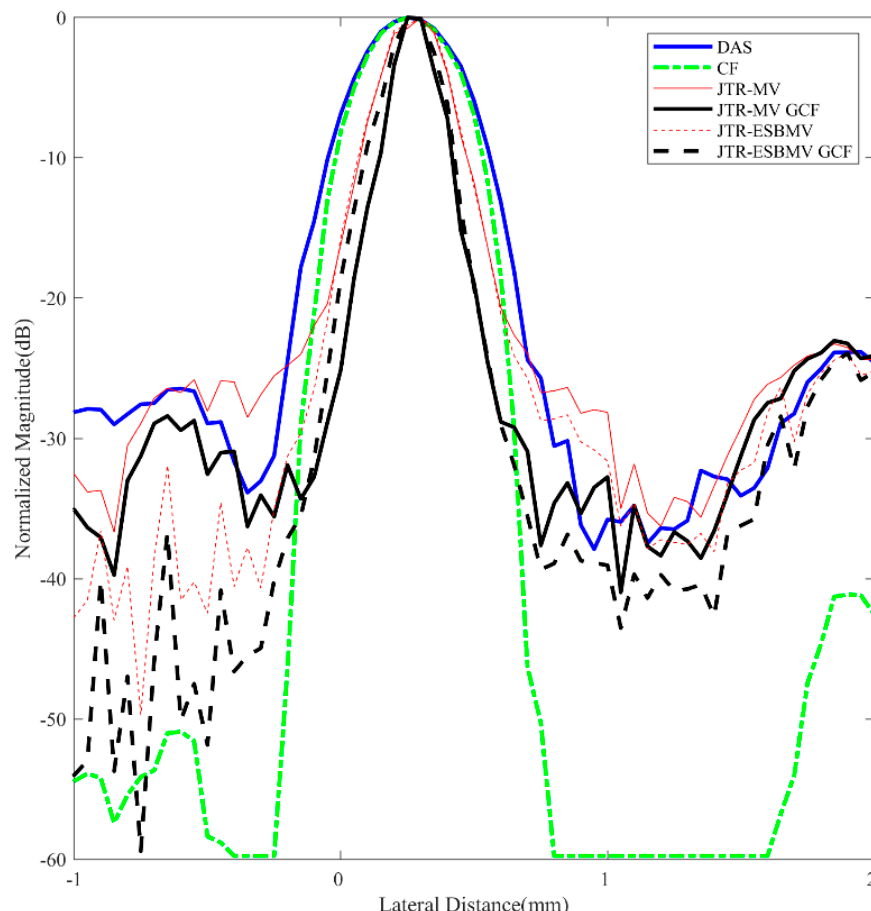
Figure 6. Lateral variations at z = 9 mm in experimental point images. Table 4. FWHM for the experimental point target at z = 9 mm.